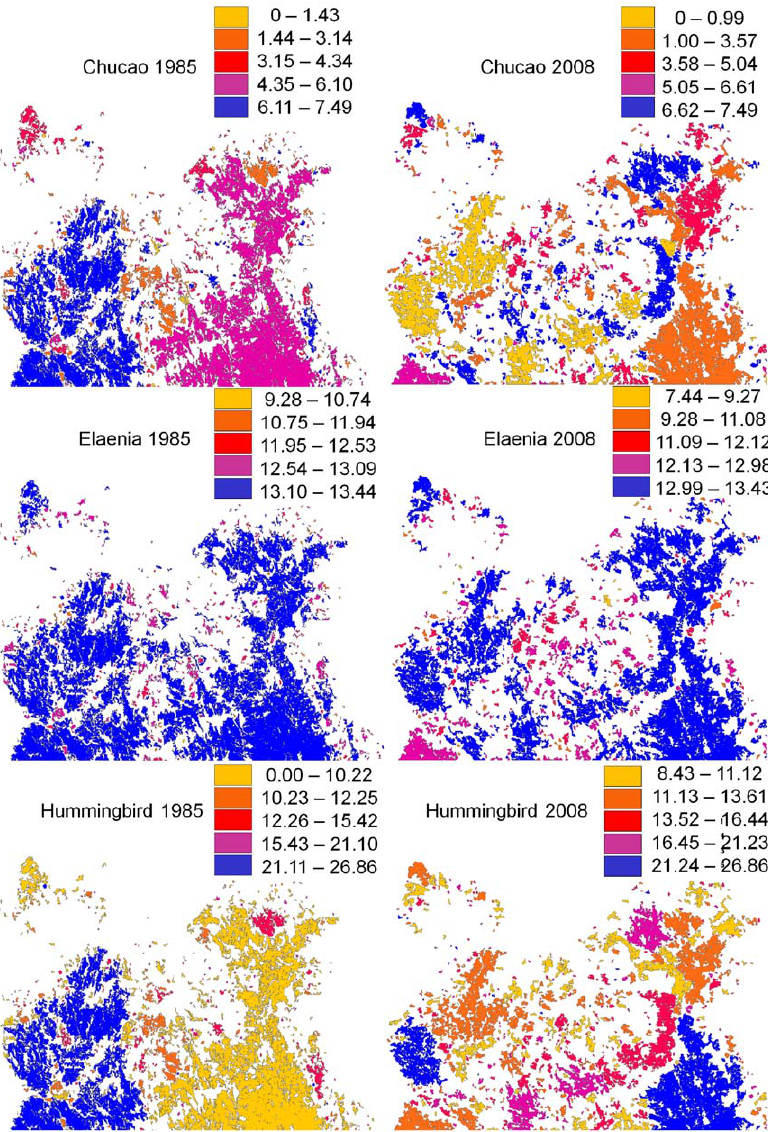
Figure 3. Estimated densities for three of the study species in 1985 and 2008. Calculations combine GLMs relating patch characteristics (size, shape and connectivity) to bird density, fitted to field data from 2008, and the analysis of patch characteristics based on satellite images from 1985 and 2008.